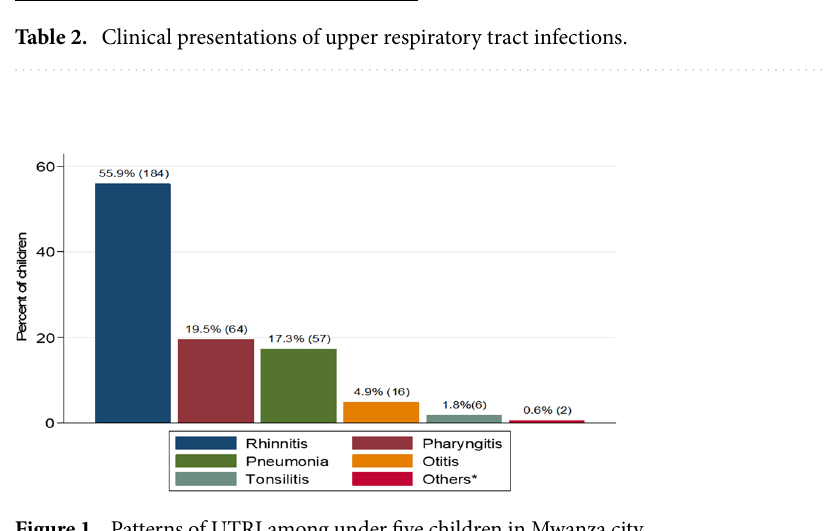
Figure 1. Patterns of UTRI among under five children in Mwanza